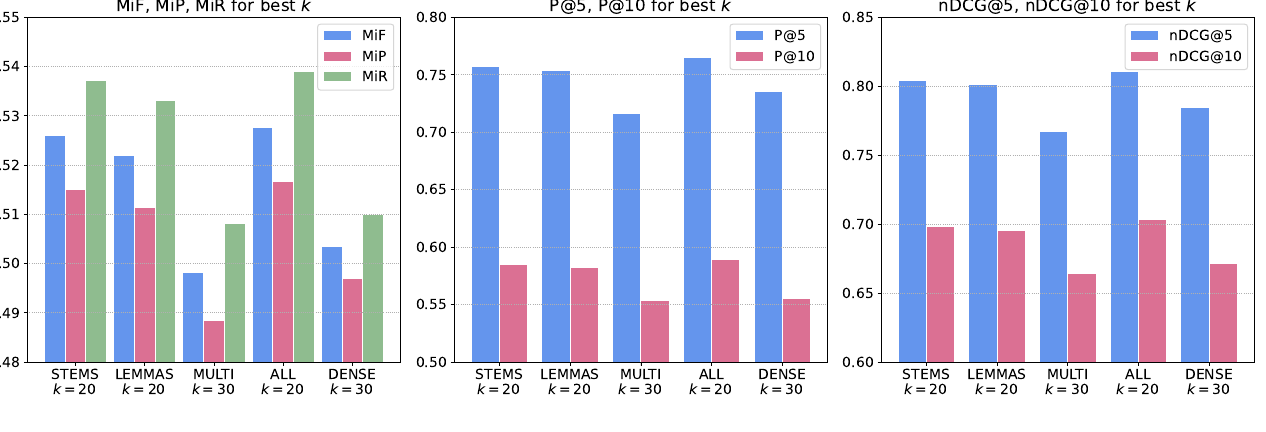
Figure 3. Summary of performance metrics with sparse vs. dense representations for values of k with best MiF